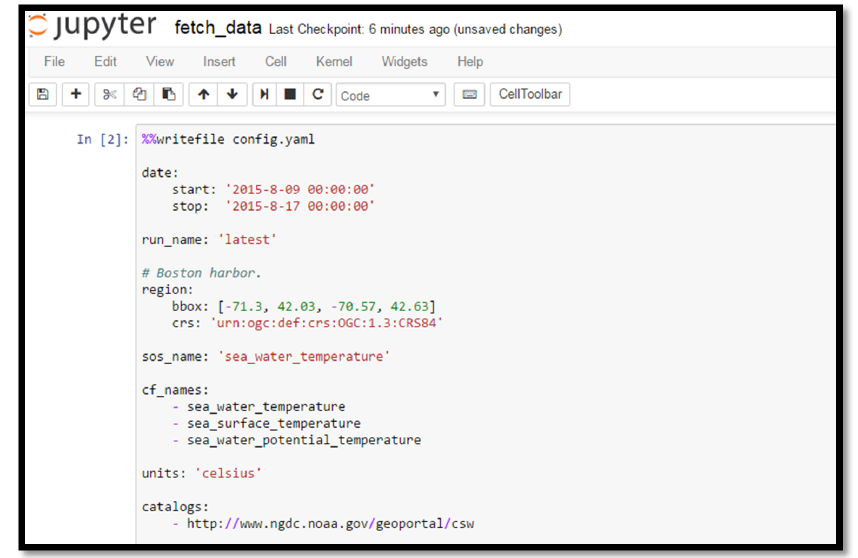
Figure 4. Screenshot from the beginning of the Fetch Data notebook, where the user specifies the date range, region, parameter of interest, and CSW catalog endpoint to search for data.